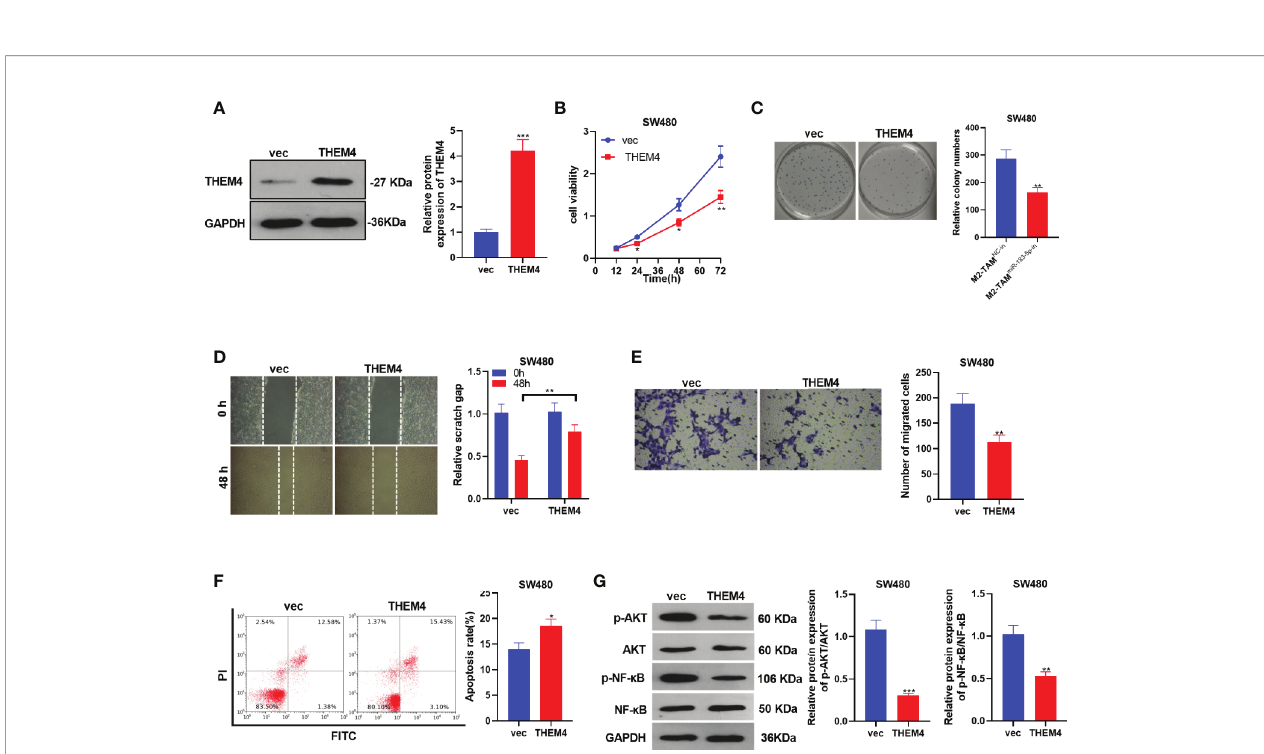
FIGURE 6 | Overexpressing THEM4 dampened the malignant phenotypes of CC. THEM4 overexpression model was established on SW480 cells. (A) The THEM4 expression was detected by WB. (B) CCK-8 assay was employed to examine CC cell proliferation. (C) Colony formation assay was applied to detect the ability of cells to form colonies. (D) Wound healing test determined cell migration. (E) Cell invasion was monitored by Transwell assay. (F) Apoptosis was determined by FCM. (G) Akt and NF- k B levels were compared by WB. * P < 0.05, ** P < 0.01, *** P < 0.001 ( vs . The M2-TAM miR-NC group).